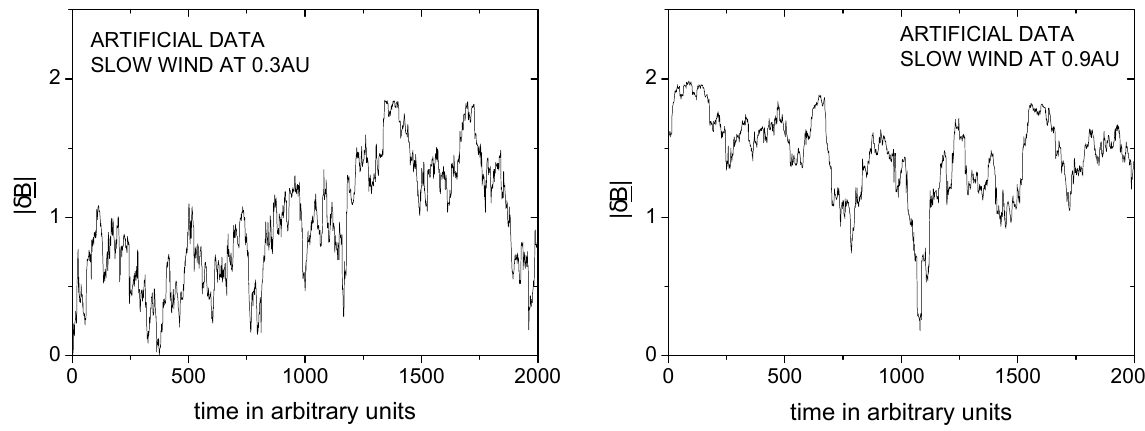
Fig. 15. Vector displacement versus time as measured from artificial data referring to a slow wind at 0.3AU on the left panel and at 0.9AU on the right panel. These plots should be compared to the top panels of Figs. 4 and 5,